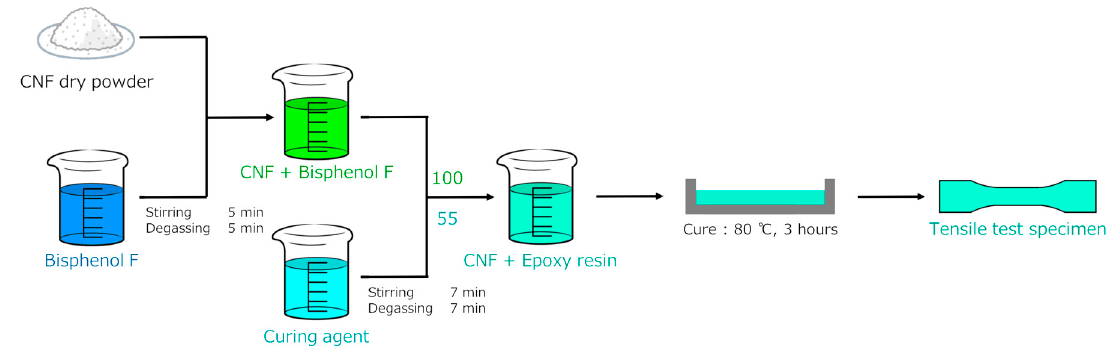
Figure 4. Schematic illustration of the preparation route for CNF/epoxy composite specimen.